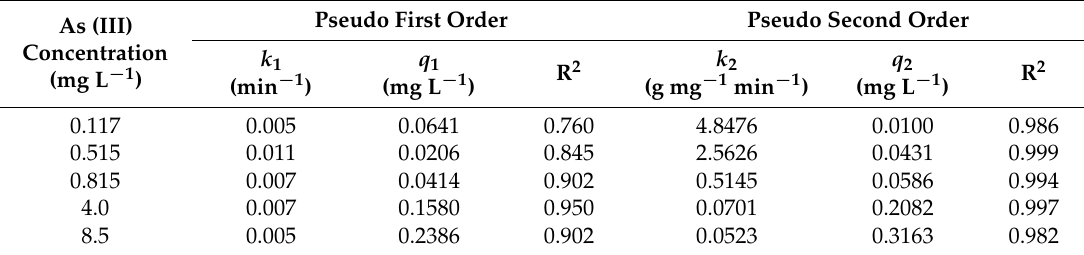
Table 2. Kinetic parameters of As (III) adsorption on Fe-modified W